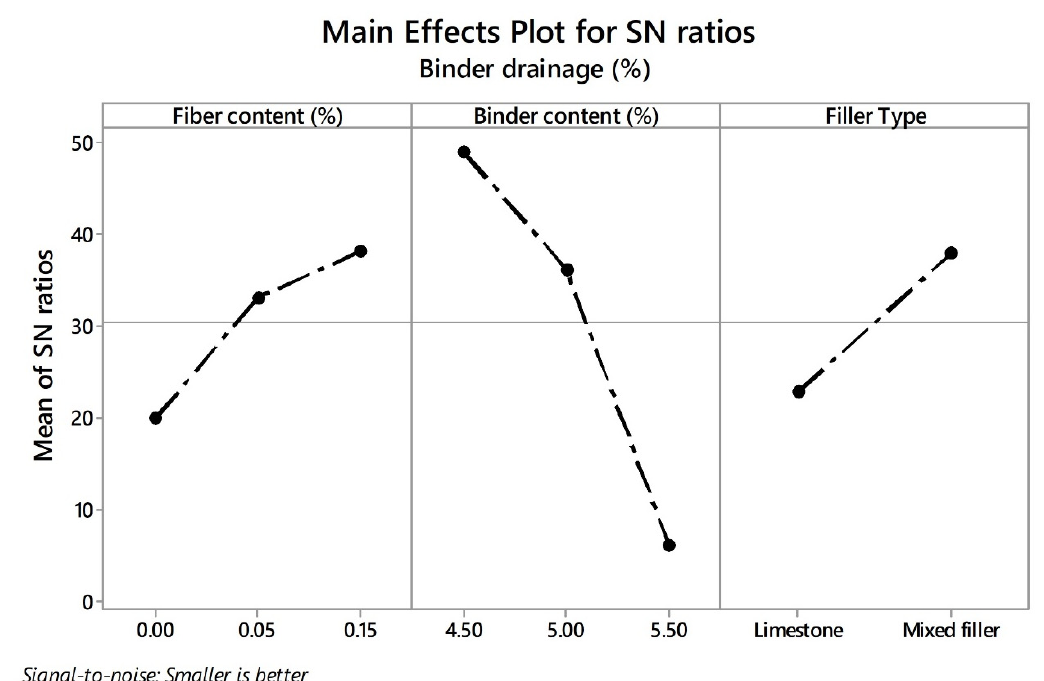
Figure 13. E ff ects of parameters on mean SN ratios for binder drainage Figure 13. Effects of parameters on mean SN ratios for binder drainage (BD). Figure 13. Effects of parameters on mean SN ratios for binder drainage (BD).